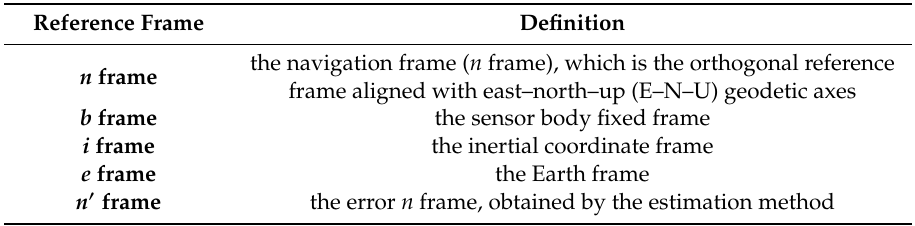
Table 1. The definition of the various reference frames in this